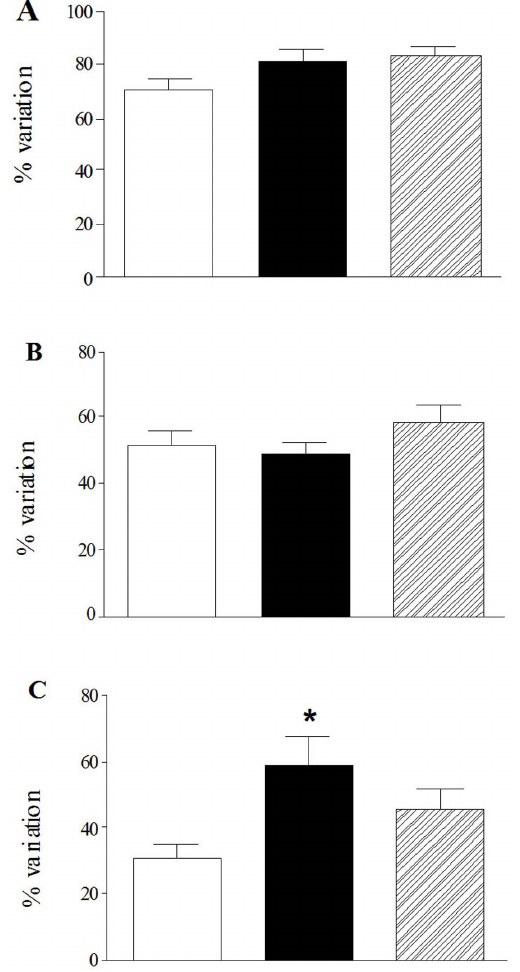
Figure 3. Effect of I/R damage on GluN 1 , GluA 1–4 and GluK 1 immunopositive myenteric neuron number. Bars indicate the percentage variation of myenteric neurons staining for GluN 1 (A), GluA 1–4 (B) and GluK 1–3 (C) in rat small intestine myenteric neuron cultures after inducing chemical ischemia (black) and after reperfusion (slash) with respect to values obtained in normal metabolic conditions (empty). Values are expressed as mean ¡ SEM of three experiments. Vertical bars indicate SEM. * P , 0.05 by one way ANOVA followed by Tukey’s test post hoc test.